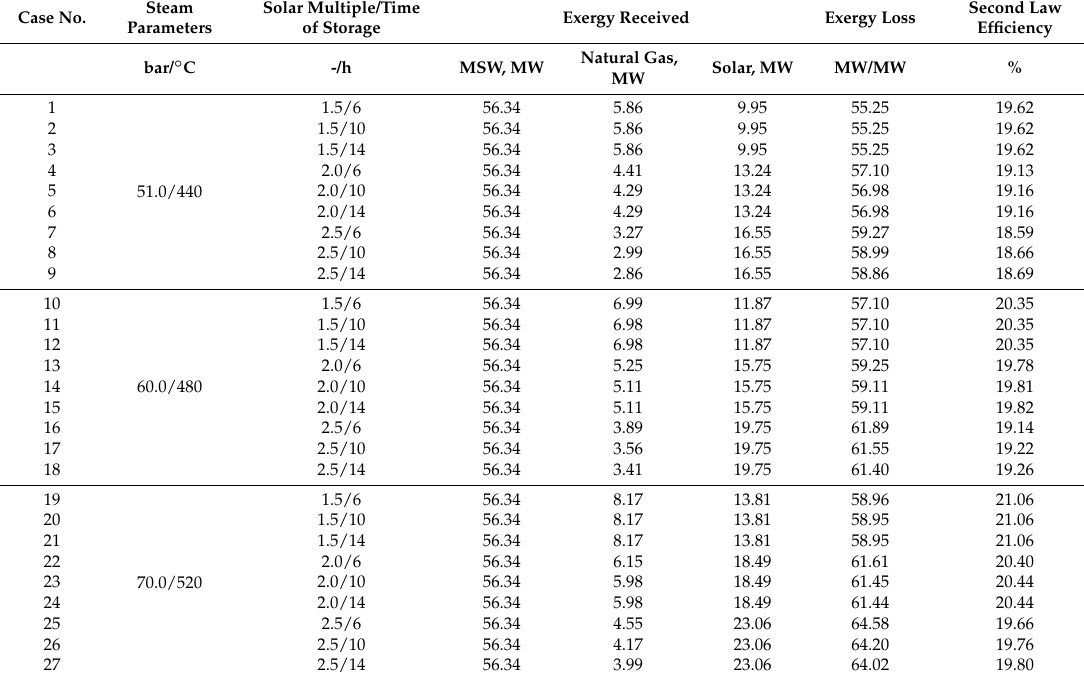
Table 4. Exergy analysis results for the cases with solar superheating.